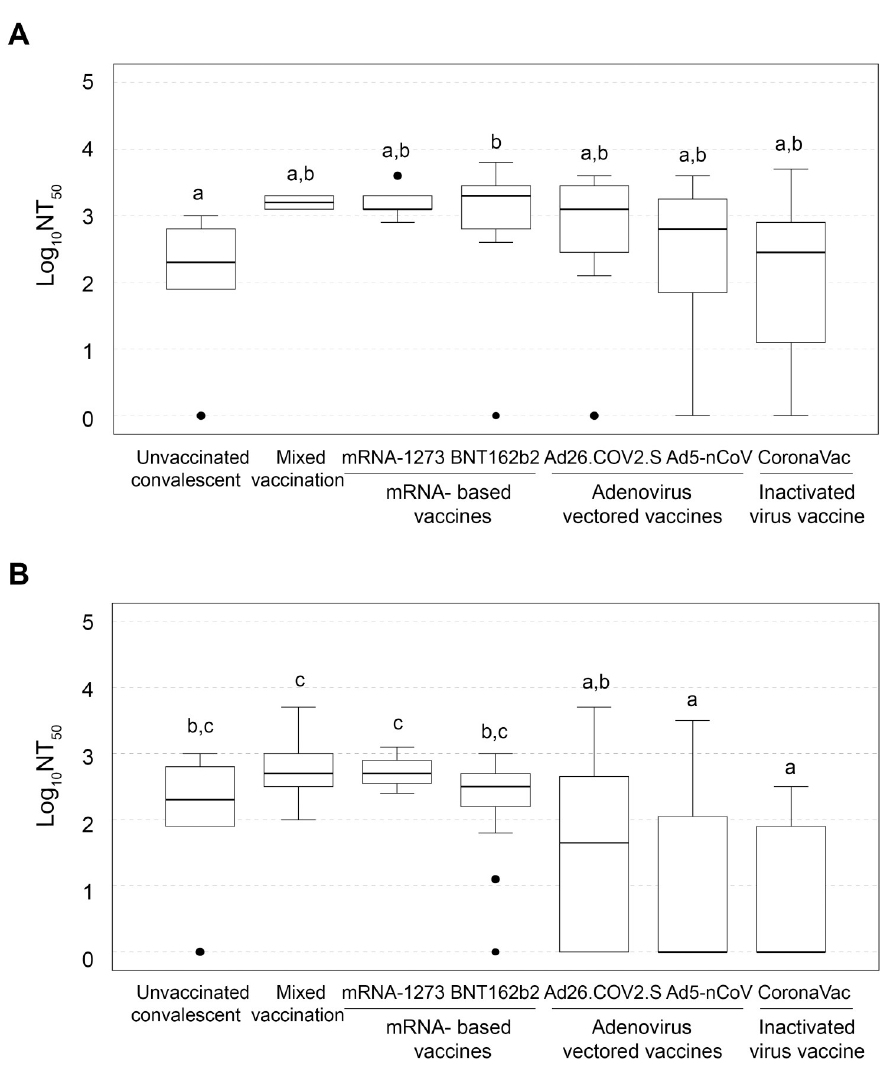
Fig 2. Immunization schemes induce differential NAb production. A) Box plot of NAb titers in convalescents, grouped by immunization scheme. B) Box plot of NAb titers on unvaccinated convalescent and vaccinated not infected, grouped by immunization scheme. The Kruskal–Wallis test compared distributions in immunization schemes; the subsets were established by a post hoc Dunn’s test (adjusted alpha = 0.07). Different letters above bars indicate significant differences between groups ( p < 0.05), while the same letter denotes similar ranks between groups ( p >